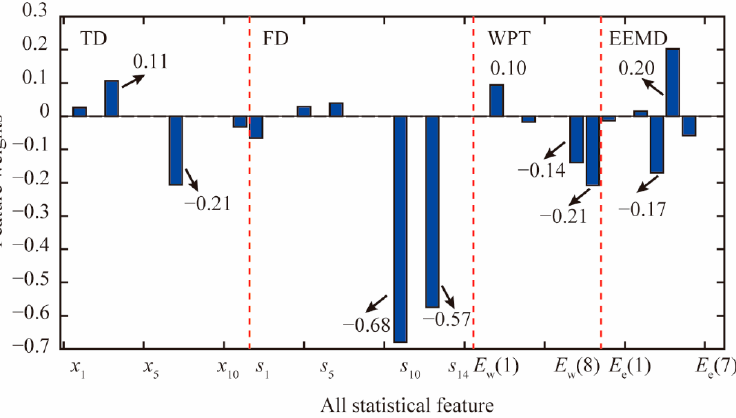
Figure 13. Weight variations of all features with C = 4.75 × 10 − 1 .